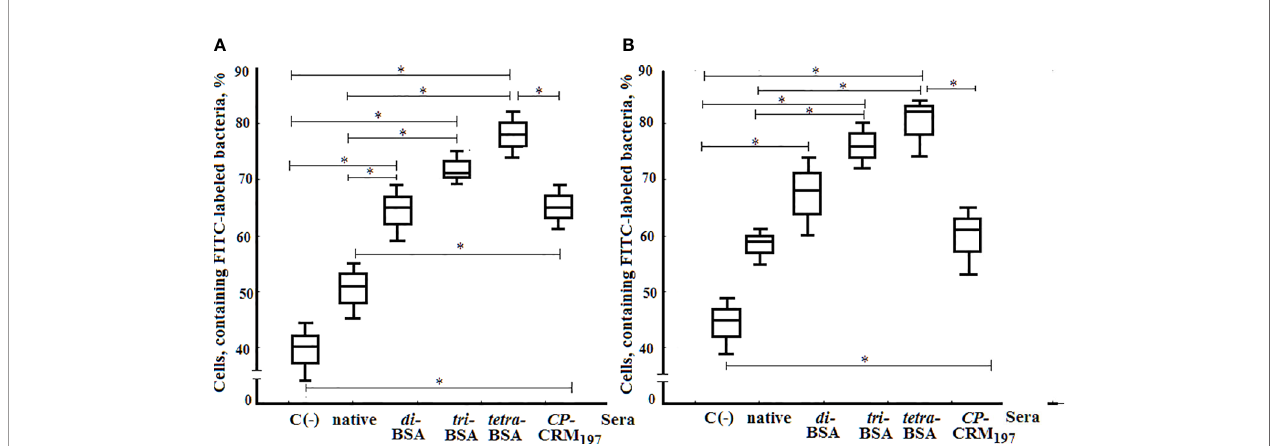
FIGURE 10 | Opsonophagocytosis observed in pooled peripheral blood samples from non-immunized BALB/c mice (n = 10) after addition of inactivated FITC- labeled S. pneumoniae type 3 (C − ), negative control; FITC-labeled bacteria with native serum; FITC-labeled bacteria treated with antisera obtained by immunization of mice with di – , tri – , and tetra – BSA conjugates adjuvanted with aluminum hydroxide and CP of S. pneumoniae type 3 CRM 197 conjugate adjuvanted with aluminum phosphate. 3 assays per sample. (A) Neutrophils measured by fl ow cytometry. (B;) Monocytes measured by fl ow cytometry. Box and whisker plots represent the distribution of cells containing FITC-labeled S. pneumoniae type 3 bacteria. The box represents 25 – 75% distribution; the enclosed line is the median, the whiskers indicate the range from 2.5 to 97.5%. Mann – Whitney Rank Sum tests were used to calculate signi fi cance, * P < 0.05.